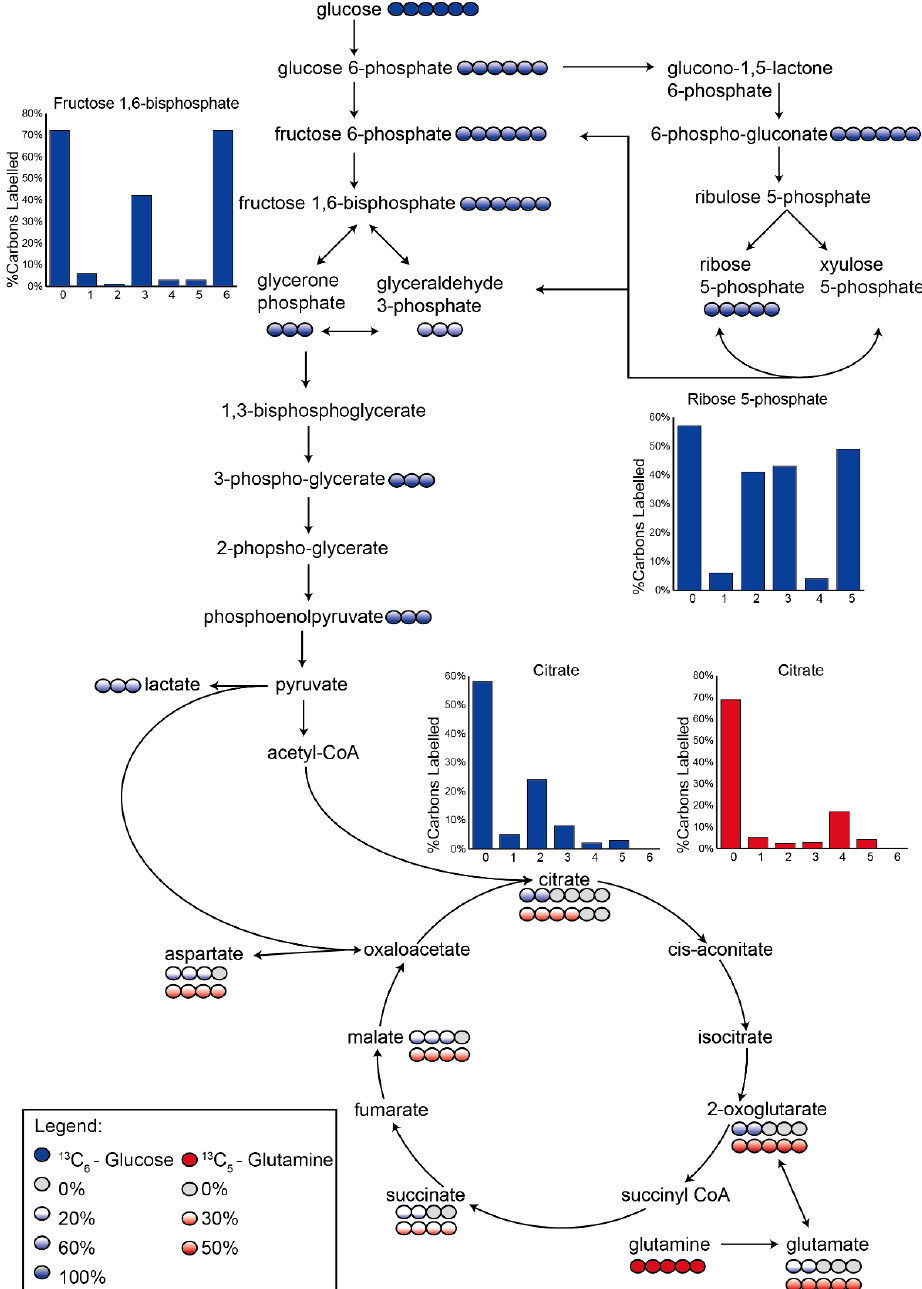
Figure 5. Schematic of central carbon pathways showing U- 13 C-glucose and U- 13 C-glutamine labelling. Incorporation of glucose (blue) or glutamine (red) into central carbon metabolism in MDA-MB-231 cells after 1 h. Circles represent the number of carbon atoms in each metabolite, with the shaded circles corresponding to the number of labelled carbons in the most abundant isotopologue. The shading intensity corresponds to the percentage of 13 C-enrichment (darker = higher enrichment), with values from 13 C-glucose labelling corrected (doubled) to allow for the 50% initial glucose enrichment. Column charts show relative isotopologue abundances for selected metabolites with complex labelling profiles ( x -axis indicates the number of 13 C-labelled carbons in each isotopologue).